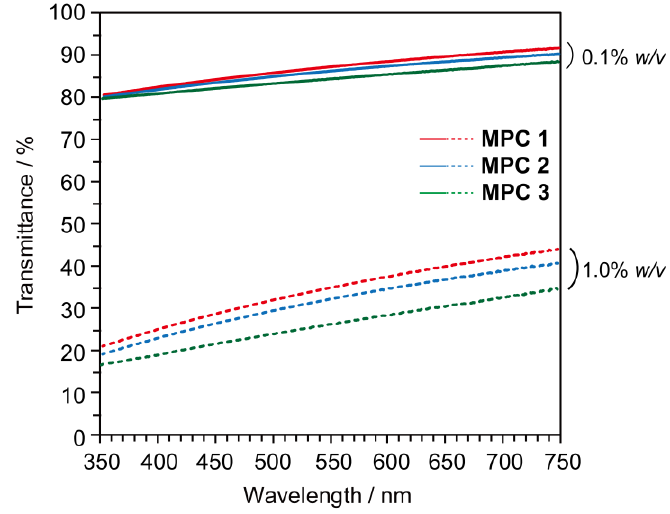
Figure 8. Transparencies of 0.1% w/v (solid lines) and 1.0% w/v (dotted lines) MPC 1‒3 dispersed in chloroform.